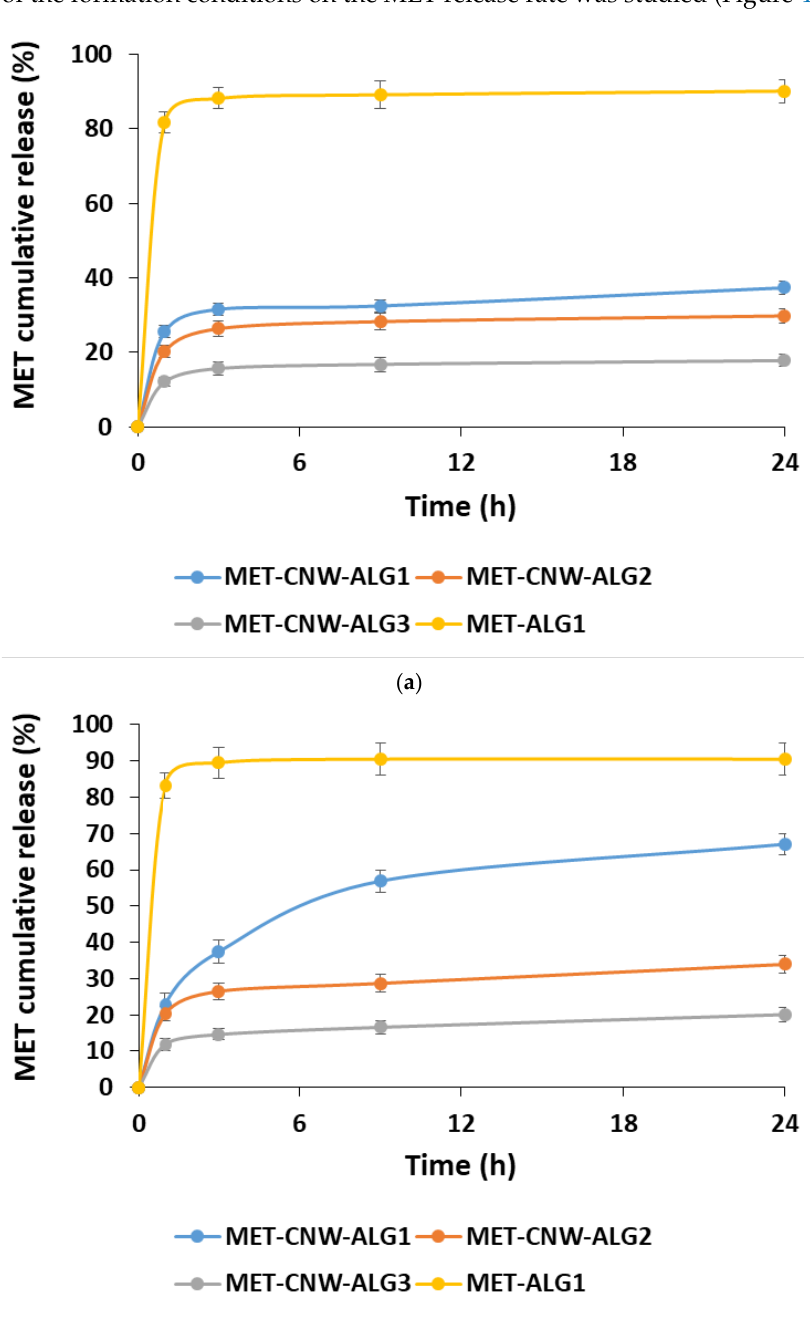
Figure 3. SEM image of CNW – ALG 1 ( a ) and MET – CNW – ALG 1 ( b ). 3.2. MET Release Kinetics from the MET – CNW – ALG The resulting polymeric complexes had a solid core (CNWs) and an amorphous shell (ALG), and this structure is usually capable of modifying the release profile of hydrophilic drugs [26]. The different swelling ability depending on the pH of the ALG amorphous shell allows the prediction of pH-sensitive drug release. These systems are suitable drug carriers with pH-dependent modified release (the contraction of the particle at a decreasing pH promotes the release of drug molecules) [45]. The kinetics of the MET release was studied using both PBS (pH 7.4) and a lactic acid solution (pH 4.5), which simulates the conditions of vaginal delivery. In this case, the effect of the formation conditions on the MET release rate was studied (Figure 4).